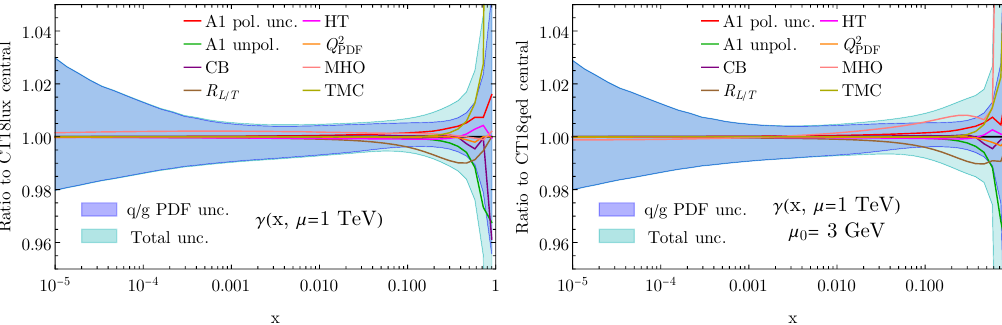
Figure 2: The individual contributions to the full γ -PDF uncertainty in the CT18lux = 3 GeV) calculations. The various sources of uncertainty and CT18qed (with µ 0 are added on top of the uncertainties associated with variations of the quark- and gluon-PDF parameters in the LUX master